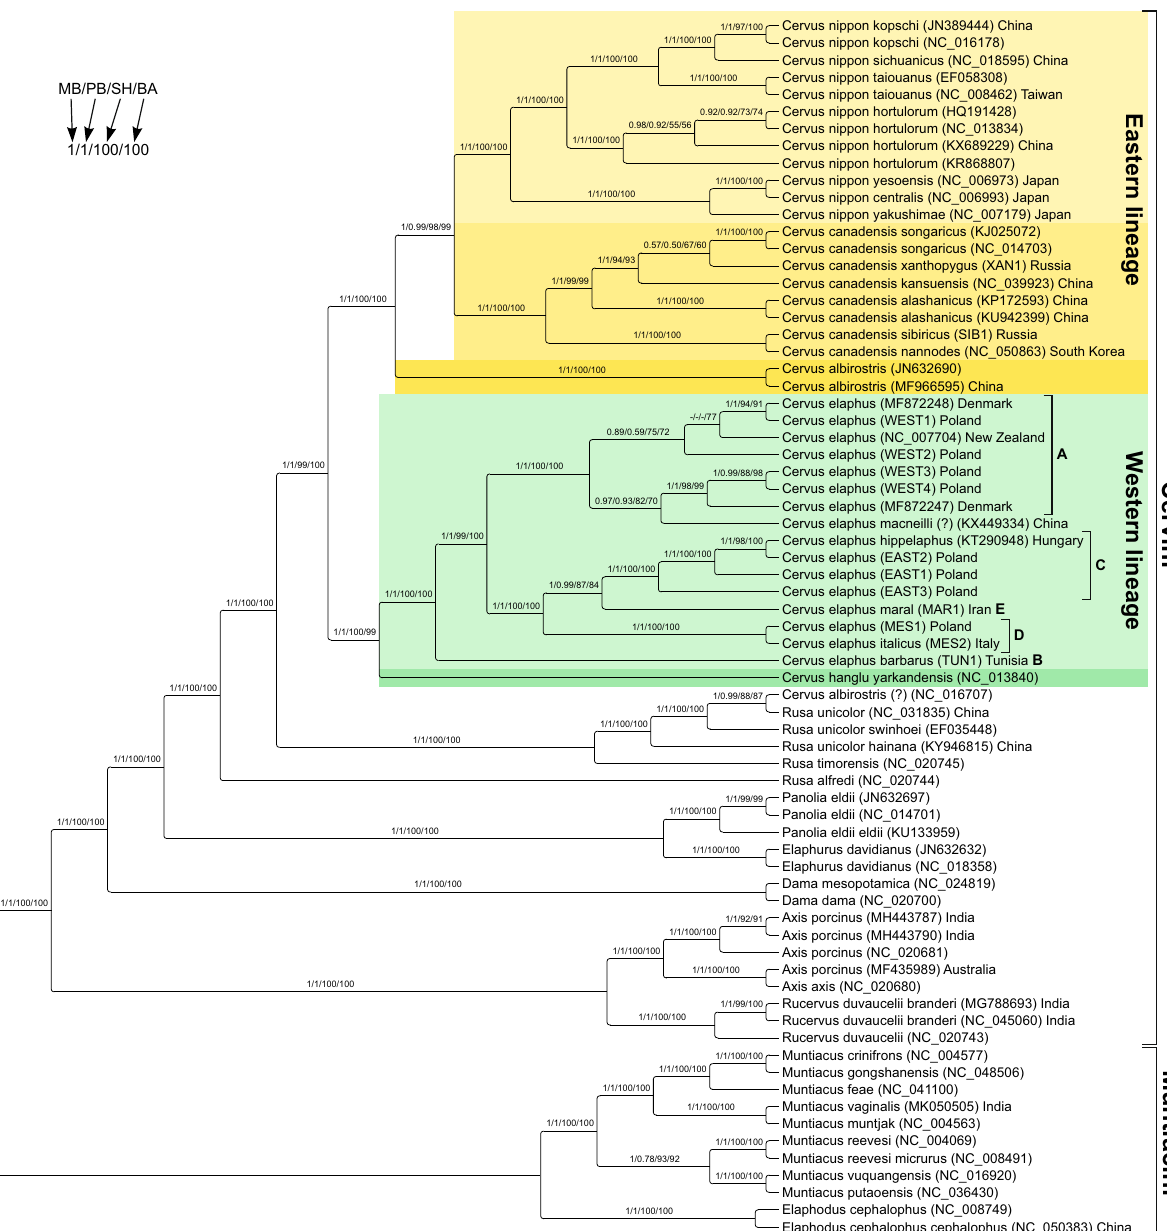
Figure 5. The consensus of trees obtained in three approaches for the alignment of control region and genes coding for 13 proteins, two rRNAs and 22 tRNAs with a total length of 16,306 bp from Cervinae (Muntiacini + Cervini). Numbers at nodes, in the following order, correspond to: posterior probabilities estimated in MrBayes (MB) and PhyloBayes (PB) as well as support values obtained by the approximate likelihood ratio test based on a Shimodaira-Hasegawa-like procedure (SH) and the bootstrap method (BA) calculated in IQ-TREE. Values of the posterior probabilities and bootstrap percentages lower than 0.50 and 50%, respectively, were indicated by a dash "–". Letters (A–E) next to Cervus elaphus clades refer to intraspecific phylogeographic haplogroups. C. albirostris (NC_016707) is likely a contamination or incorrect labelling because its sequence is more similar to Rusa unicolor than other samples of R. unicolor to each other, whereas two other sequences assigned to C. albirostris are clearly separated from NC_016707 and are grouped with Cervus sequences with high support. The same holds for C. elaphus macneilli (KX449334), which is a subspecies of the wapiti native to Western China and typically called C. canadensis macneilli . Therefore, this sample could also be mislabelled or contaminated. Alternatively, these two specimens can be a result of mitochondrial introgression. C. canadensis nannodes sample (NC_050863) was translocated or imported for farming to South Korea 120 from its native site in California in North America. The specimen C. elaphus (NC_007704) from New Zealand is also an introduction by